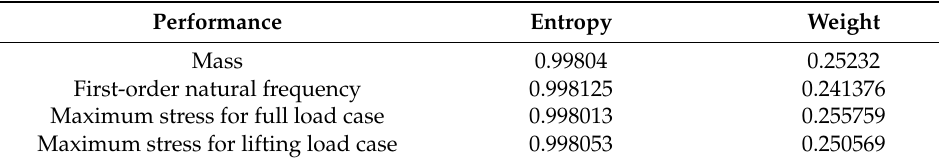
Table 5. Weight coefficient of performance index.